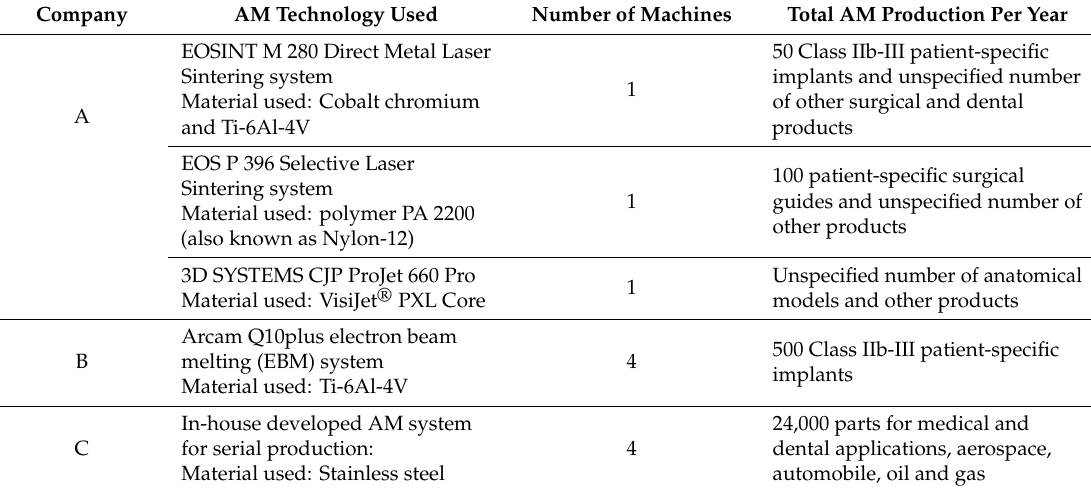
Table 4. Summary of AM production rates and the technologies used by Companies A, B, and C. Company